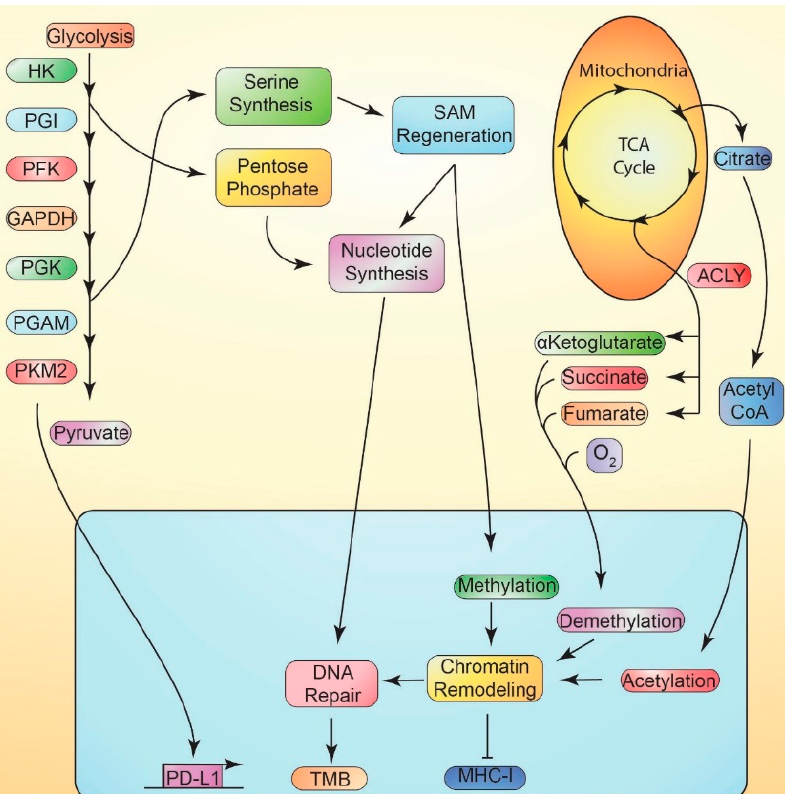
Figure 4. Tumor cell-intrinsic metabolic regulation of immune escape. High rates of glycolysis in tumor cells, enabled by increased expression of PKM2 (pyryvate kinase muscle 2), supply intermediates required for serine biosynthesis and pentose phosphate metabolism. PKM2 can directly promote the expression of PD-L1 (programmed death ligand 1) independent of its regulation of glycolytic metabolism. Pentose phosphate metabolism (PPP) is required for nucleotide biosynthesis. Serine biosynthesis readily supplies carbon for the regeneration of S-adenosyl methionine (SAM), which is required for both nucleotide biosynthesis and chromatin remodeling via methylation. Nucleotide biosynthesis supplies required nucleotides for DNA repair following damage. Tricarboxylic acid cycle metabolic intermediates also regulate chromatin remodeling. Citrate, exported to the cytoplasm, supplies substantial amounts of acetyl CoA via ATP citrate lyase (ACLY), required for acetylation. Alpha-ketoglutarate, succinate, fumarate, and oxygen regulate a range of demethylation reactions, either as substrates or as inhibitors. Chromatin remodeling is essential to efficient DNA repair, failure of which drives an increase in TMB. Further, MHC-I (major histocompatibility complex class I ) is epigenetically suppressed by many cancer